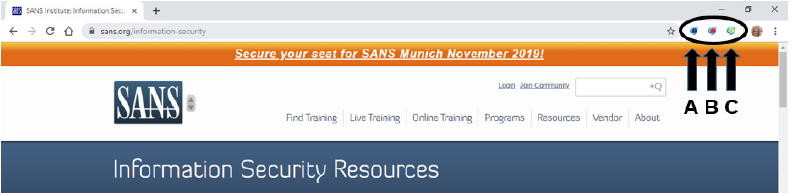
Figure 1. SAWIT add-on toolbar. ( A ) Knowledge Sharing; ( B ) Security Resources; ( C ) Assessment